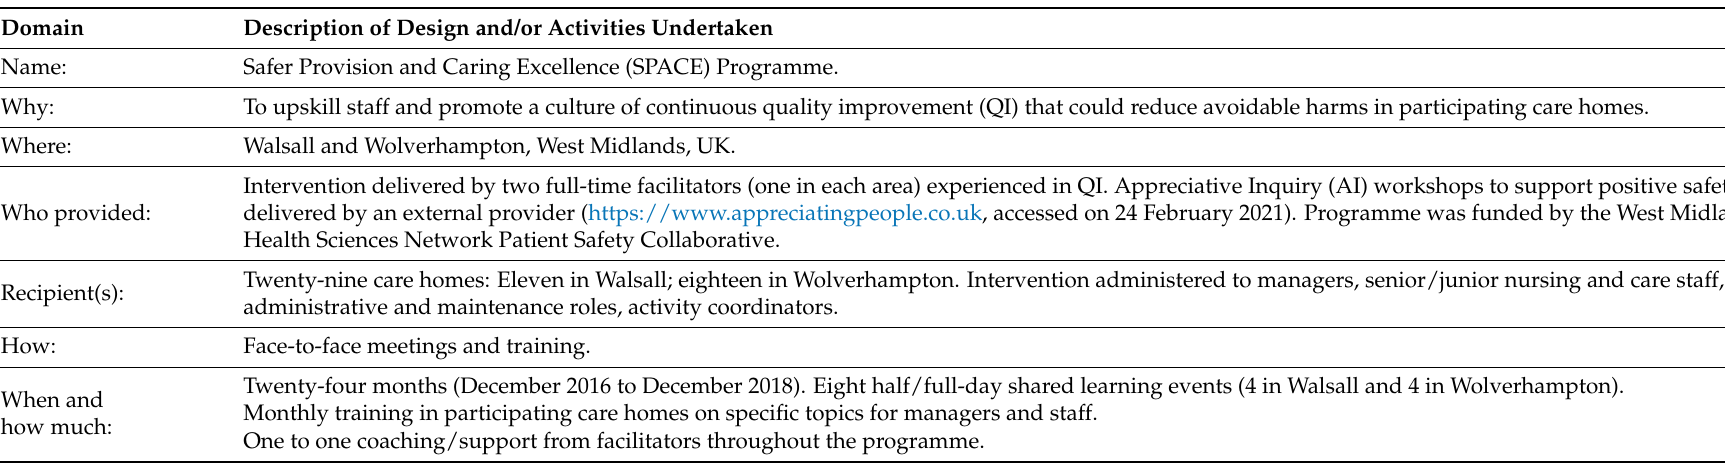
Table 1. Detailed description of the SPACE quality improvement